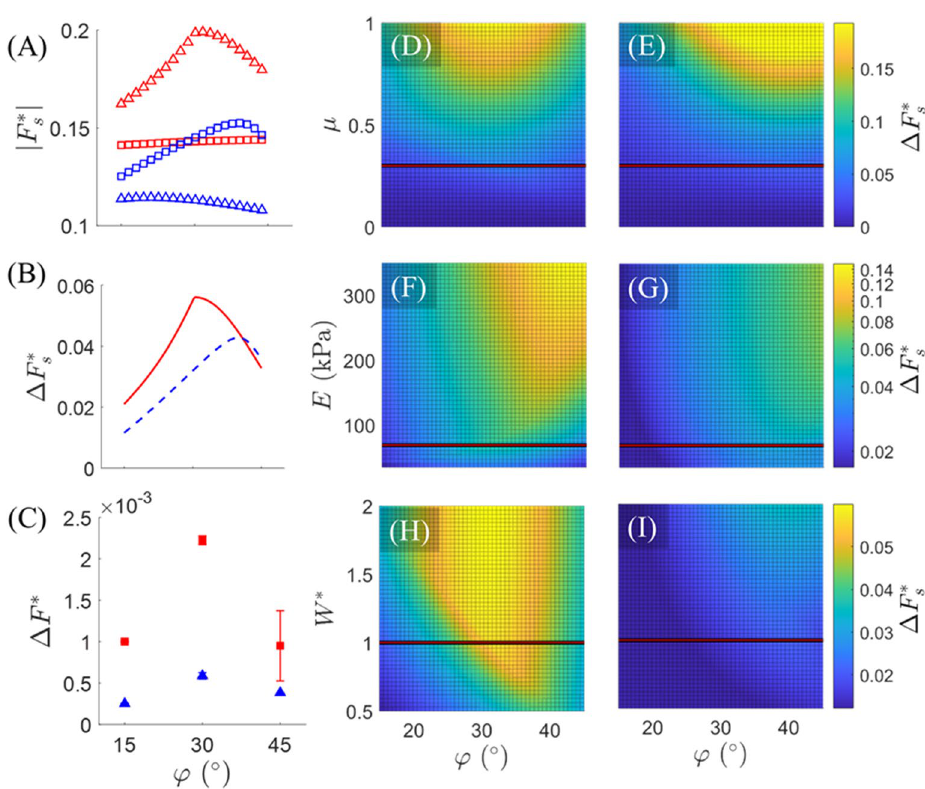
Figure 5. Model results. ( A ) The magnitude of static friction force (normalized by mag-bot weight), as predicted by the model, is plotted with respect to ϕ for Type I.e (red squares), Type II.e (red triangles), Type I.b (blue triangles), and Type II.b (blue squares) deformation types. ( B ) The difference in forefoot (squares) and hindfoot (triangles) static friction (normalized by mag-bot weight), as predicted by the model, for both extension (solid red line) and bending (dashed blue line) is plotted with respect to ϕ . ( C ) The experimentally estimated mean unbalanced force during both extension (red squares) and bending (blue triangles), is plotted with respect to ϕ . ( D,E ) Model-predicted values of normalized net friction ( � F ∗ s = ( F + − F − )/ mg ) with respect to ϕ and ( D,E ) friction coefficient ( µ ), ( F,G ) skin modulus ( E ), and ( H,I ) normalized weight ( W ∗ = m / [ 6.1 × 10 − 4 kg ] ). ( D,F,H ) Represent extension, while ( E,G,I ) represent bending. ( D–I ) Horizontal lines represent the parametric slice presented in ( B ) (for which µ = 0.3 , E = 69kPa , and m = 6.1 × 10 4 kg , the latter two of which are based on the true mag-bot